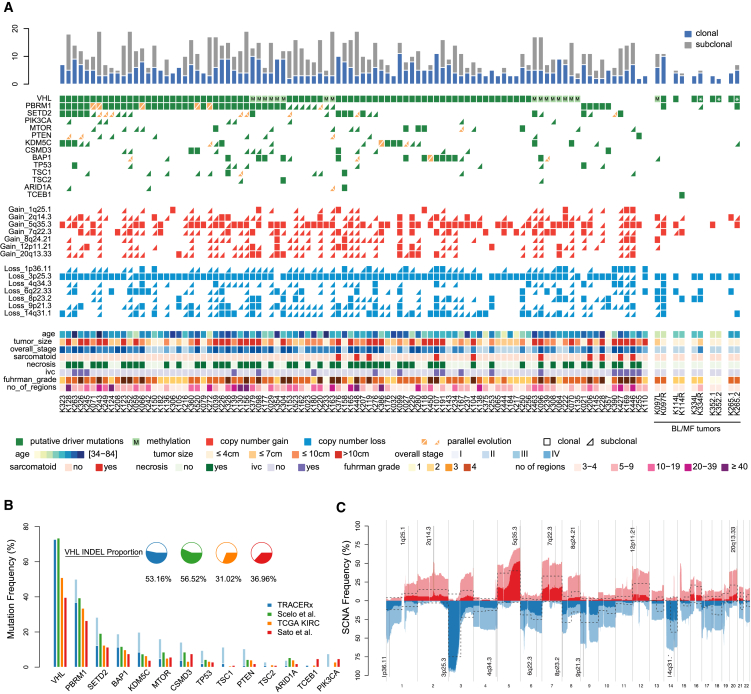
Overview(A) Overview of somatic driver alterations, including SNVs, DNVs, INDELs, and SCNAs, detected in the tumors of 101 TRACERx Renal cases. Rectangles and triangles indicate clonal and subclonal alterations, respectively. Parallel evolution is indicated in orange with a split indicating 2 or more parallel events. Five bilateral/multi-focal cases are shown on the right; distinct VHL mutations within tumor pairs are indicated with an asterisk.(B) Mutational frequency in 14 key driver genes in the TRACERx Renal cohort and three single biopsy ccRCC studies (TCGA KIRC, Sato et al. [2013], and Scelo et al. [2014]). Clonal mutations are shown in the darker shade, subclonal in lighter.(C) Frequency of SCNAs in the TRACERx Renal cohort. Copy number gains and losses are indicated in red and blue respectively. Clonal SCNAs are shown in darker and subclonal SCNAs in lighter shade of color. Putative driver copy number altered regions are annotated. The dotted line indicates the frequency of the same SCNAs in the TCGA KIRC cohort.See also Tables S1 and S2 and Data S1, S2, S3, and S4.